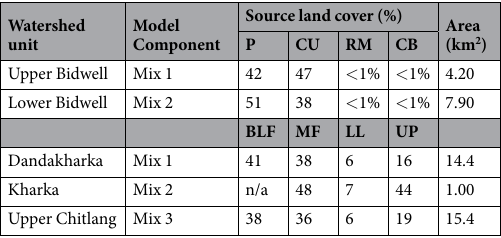
Table 1. Sampled source distributions in (sub) watersheds of the Bidwell watershed (UK) and the Chitlang watershed (Nepal) where P = pasture, CU = cultivated land, RM = road-derived material and CB = channel bank, BLF = broad leaf forest, MF = mixed forest, LL = lowland terraces and UP = upland terraces. Mix 1–2 (Bidwell) and Mix 1–3 (Chitlang) refer to Fig. 1b and c respectively. Note the remainder of land cover in Bidwell Brook is largely stable woodland which was not included in the